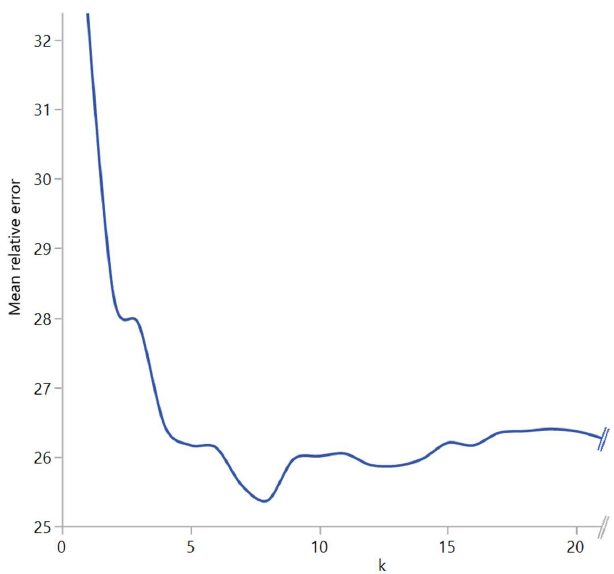
Figure 1. Detail of the brute force approach to find ideal k in k -nearest neighbour analysis. The mean relative error of the RV%TLC prediction is shown for various k s.